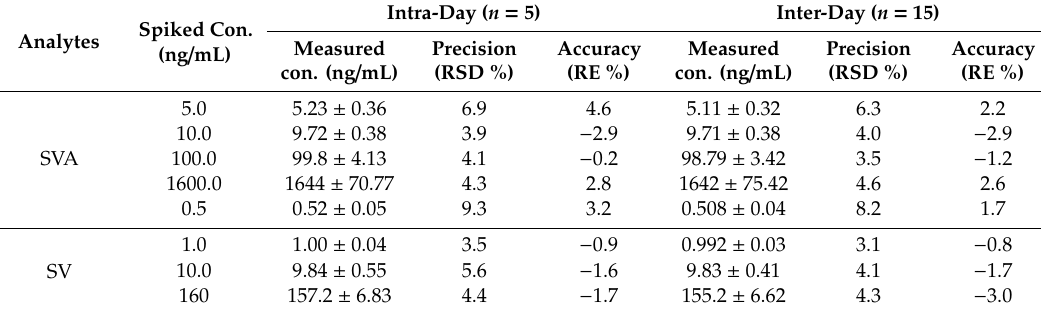
Table 2. Precision and accuracy of SVA and SV in rat plasma (mean ± S.D, n = 5).